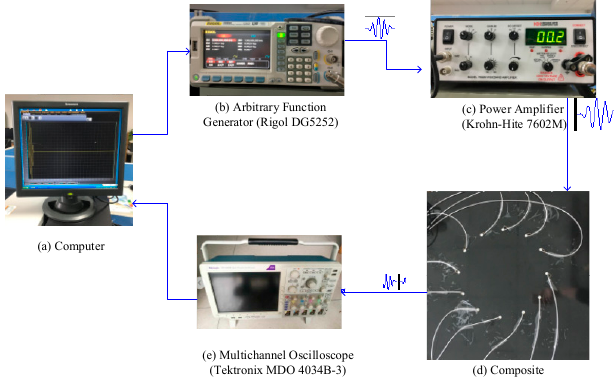
Figure 7. Photographs for the experimental system of Lamb wave tomography.